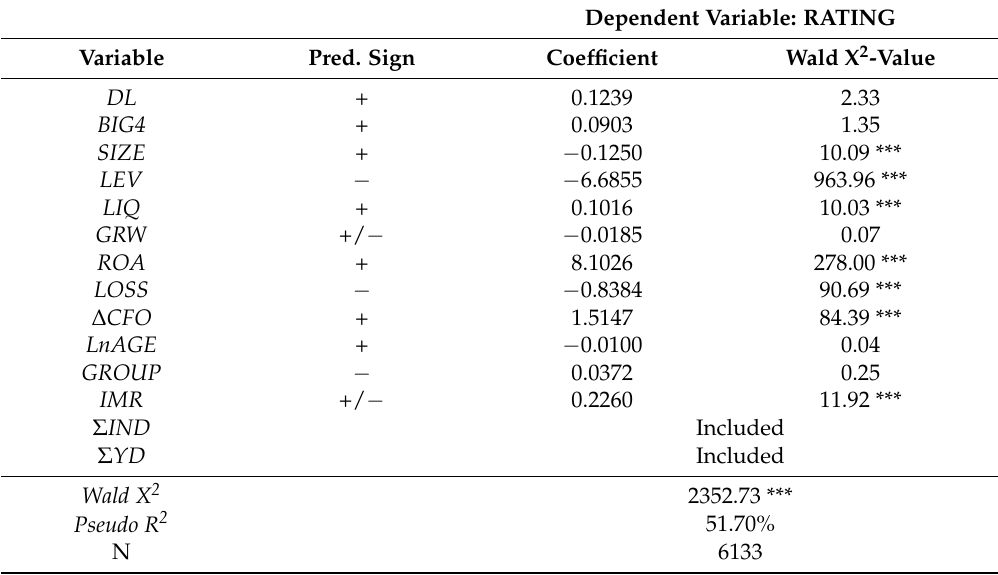
Table 5. Cluster-adjusted ordered probit regression results for